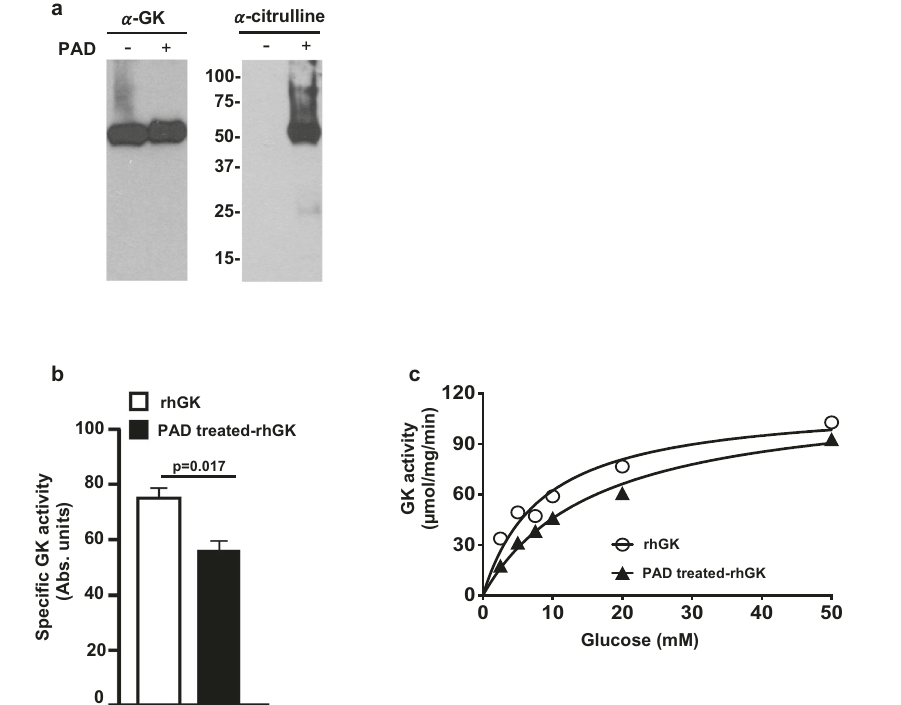
Fig. 5 Citrullination modi fi cations in human pancreatic glucokinase. a The citrullinated-rhGK was generated as described in Methods based on in vitro citrullination by PAD. The native and PAD treated-rhGK were subjected to electrophoresis and followed by immunoblot with anti-glucokinase ( α -GK) and anti-citrulline ( α -citrulline). b The catalytic activity was measured spectrophotometrically at 25 mM glucose on 1 µ g of rhGK and PAD treated-rhGK, respectively (see Methods). The error bars indicated SD of mean. c Enzyme kinetic analysis of GK was measured with seven dilutions of glucose (0 – 50 mM) and analyzed using GraphPad Prism Software. Km and Vmax were calculated by rhGK and PAD-treated rhGK curves, respectively, with p value of 0.0093 (computed by the F-test) between two Michaelis – Menten